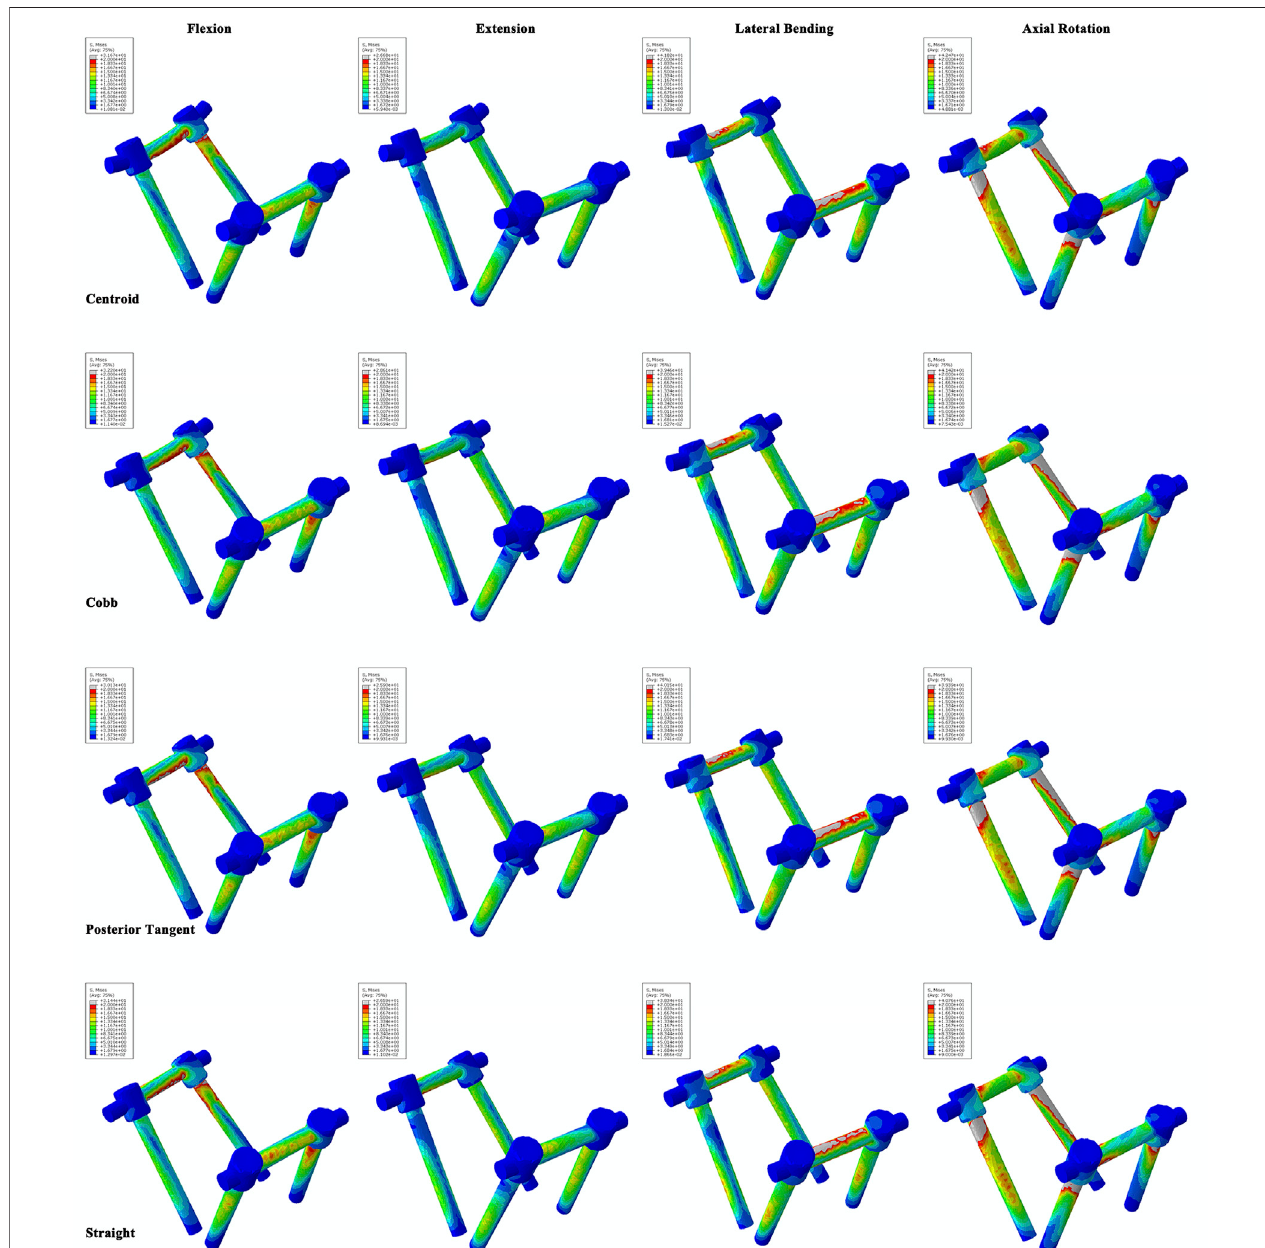
FIGURE 7 | Stress contours of the screw – rod system for four RC models under fl exion, extension, lateral bending, and axial rotation tests.